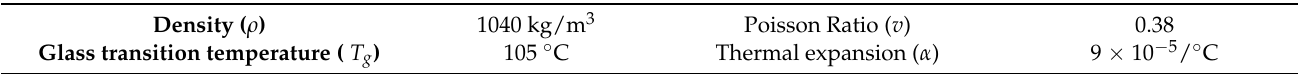
Table 1. Constant material